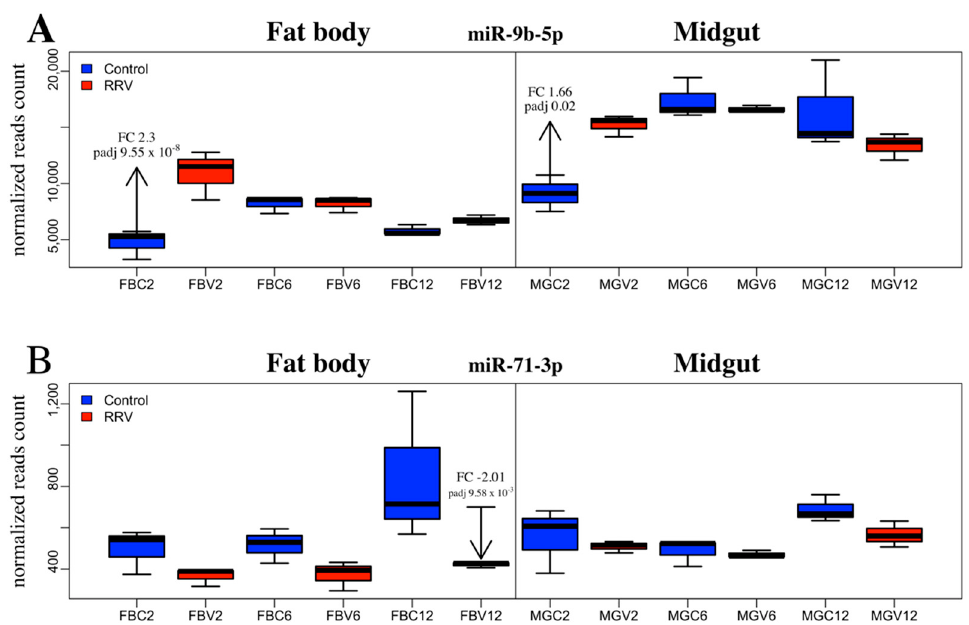
Figure 5. Ae. aegypti miRNA di ff erential expression due to RRV infection between tissues and across time. The expression profile of ( A ) miR-9b-5p and ( B ) miR-71-3p, in control (blue) and infected (red) fat body and midgut samples at 2, 6, and 12 dpi. Significant changes are labelled with the fold change (FC) and adjusted p -value (padj). The boxplot and whiskers show the mean of the normalized reads counts of the biological replicates ( N = 3).